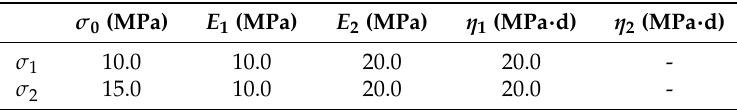
Figure 8. Comparison of creep strains between single-step loading and multi-step loading for H-K model. Table 3. Parameters of the H-K model.